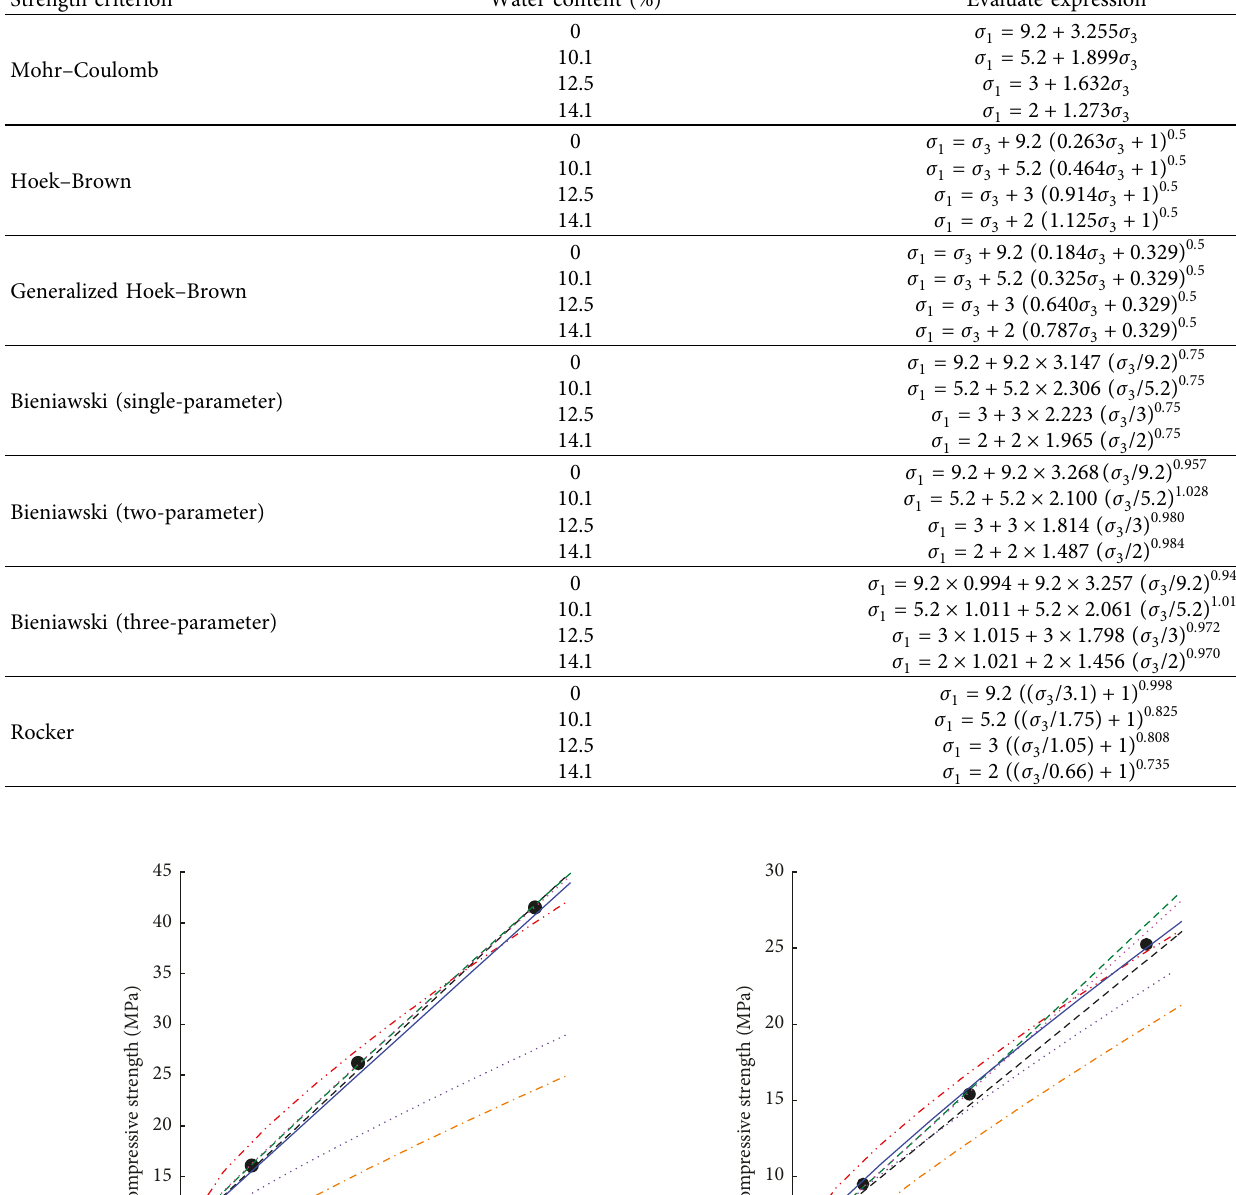
Table 2: Calculation expression of the strength criterion under different water